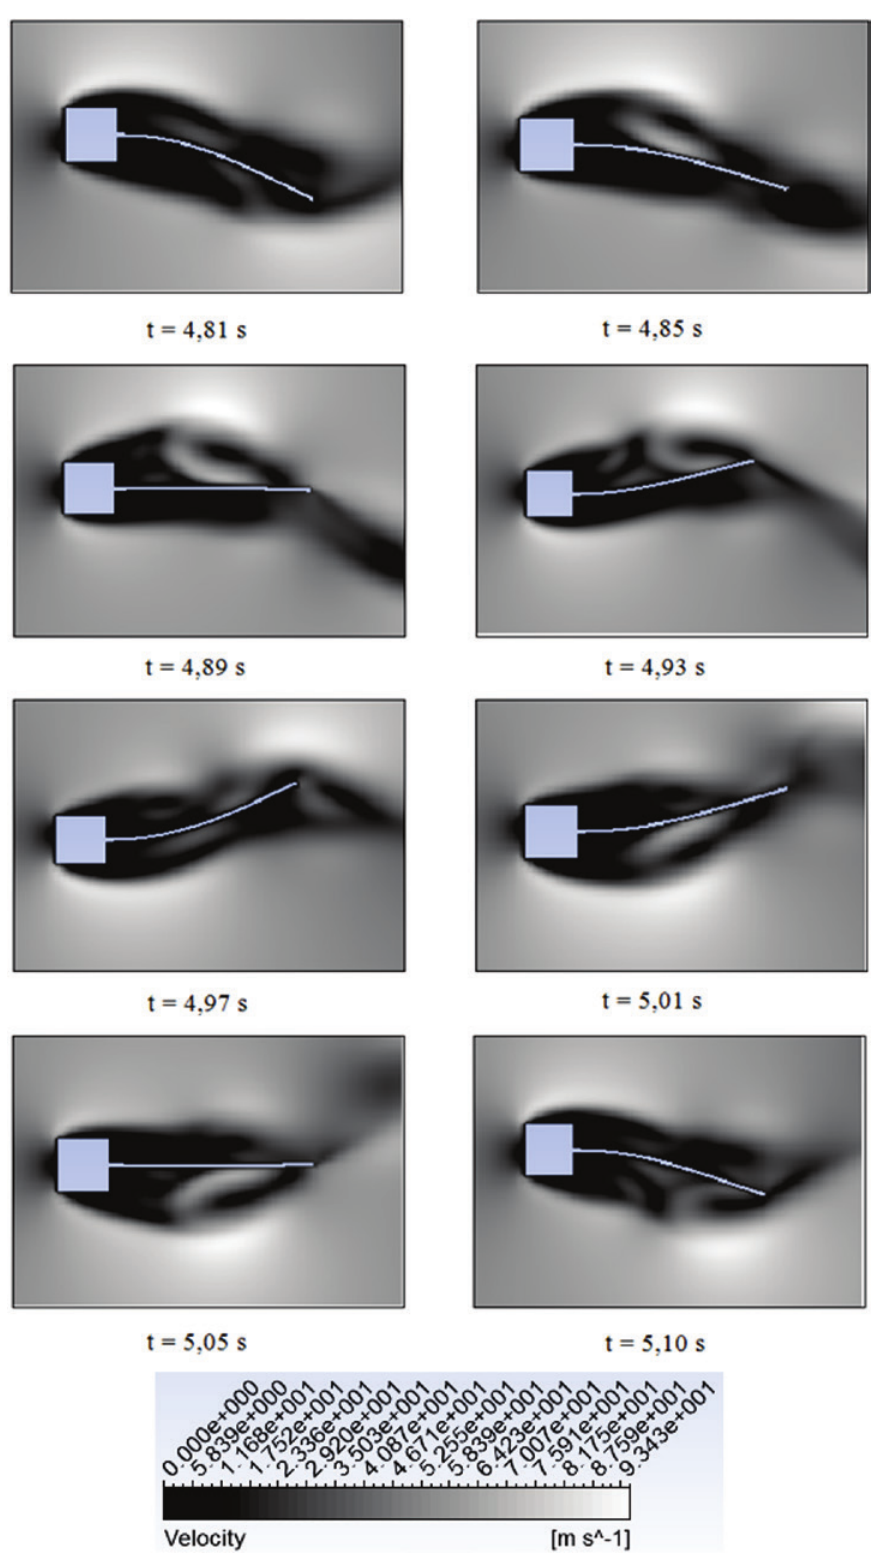
Vibração de uma viga induzida por um fluxo de um